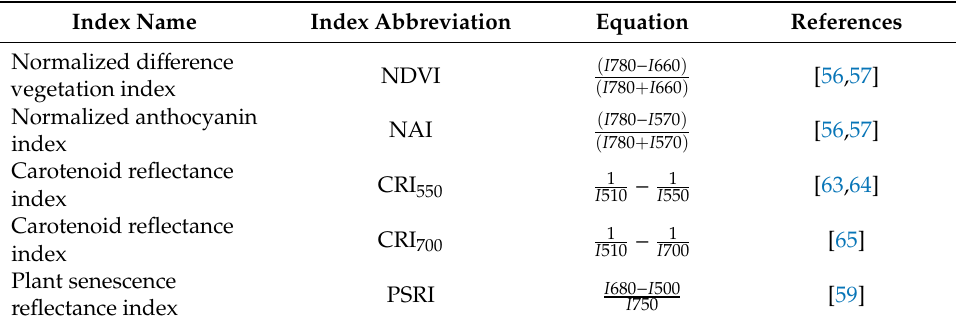
Table 1. Calculations for the spectral indices investigated in this